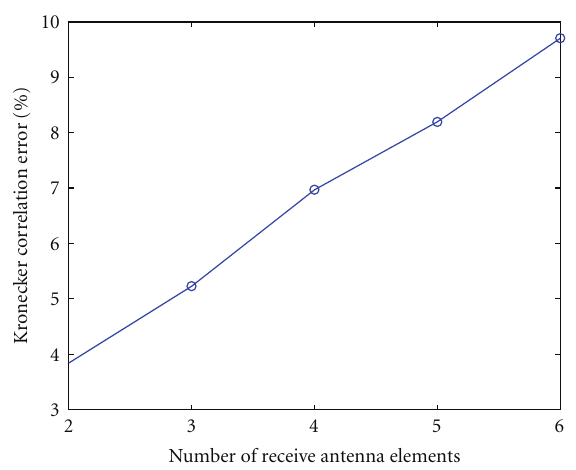
Figure 2: Kronecker correlation error as a function of receive monopole number with the three wall antennas fixed as transmit antenna.